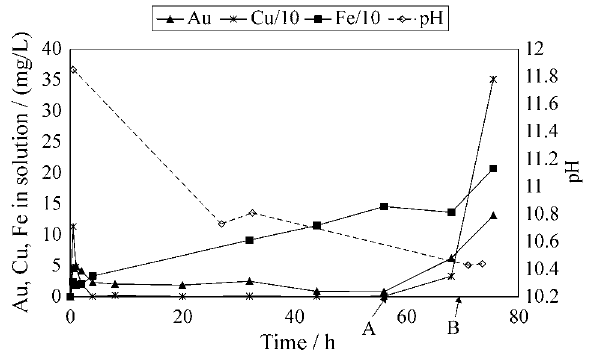
Figure 3. Product cyanidation using 2.5% NaCN solution; 1 kg of product, 1 L of solution, 71 g of lime; 25 g NaCN were added to the pulp at time A. Au recovery = 61.2%.